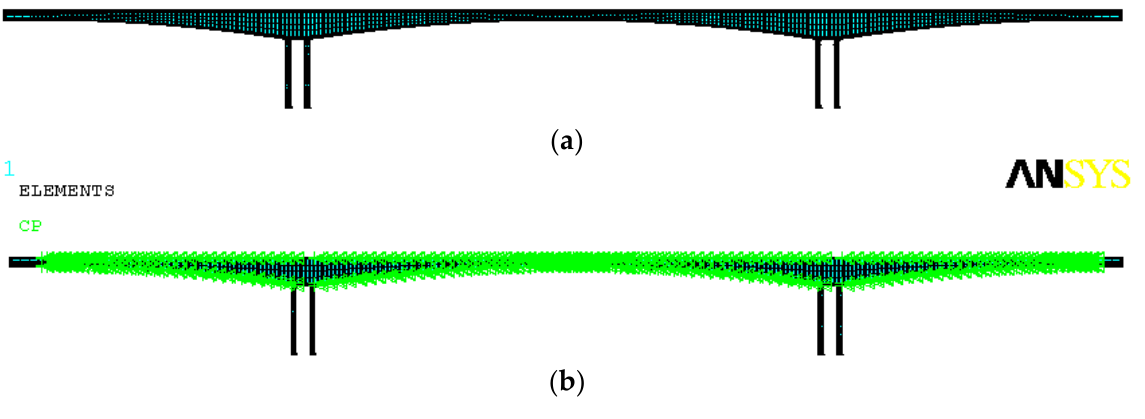
Figure 10. ANSYS finite element models of the Assistant Shipping Channel Bridge of Humen Bridge. ( a ) Whole model of the Assistant Shipping Channel Bridge of Humen Bridge. ( b ) Model with joints of the Assistant Shipping Channel Bridge of Humen